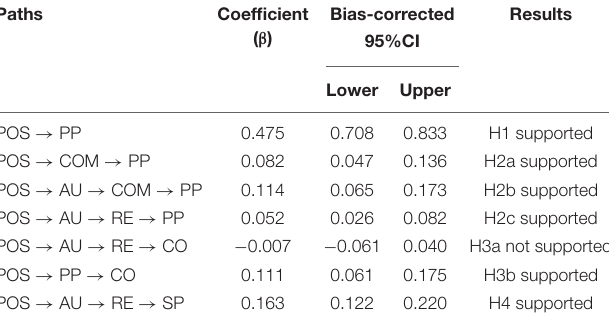
TABLE 4 | Bootstrap test for mediating effect.